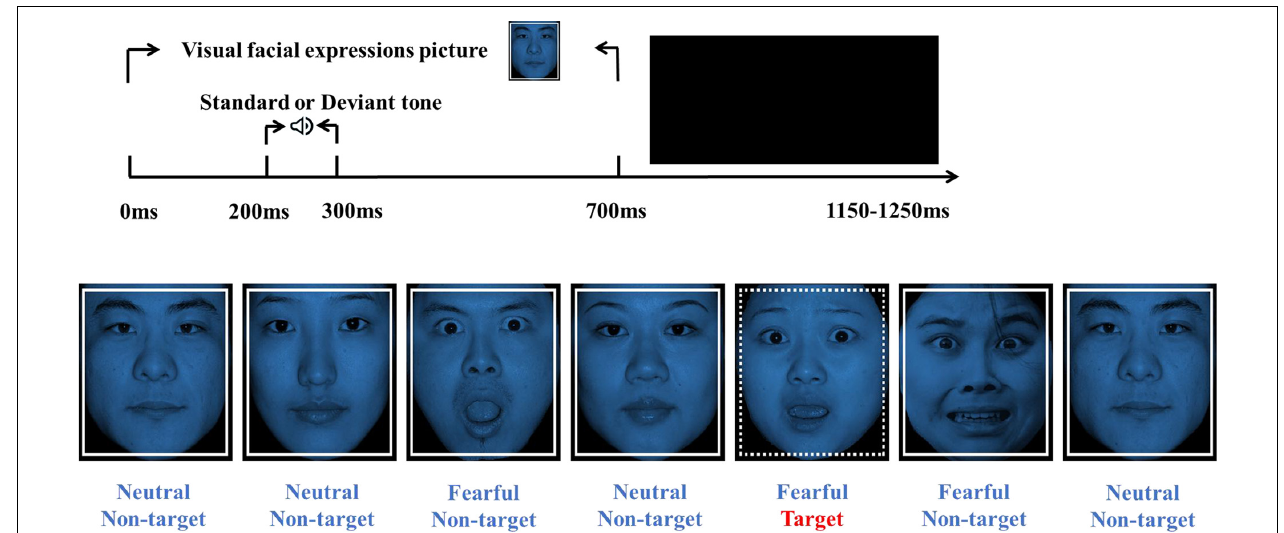
FIGURE 1 | Experimental design and a visual stimuli example. The time course of the oddball paradigm (up). Each visual facial expression picture (Non-target/Target stimulation) was presented for 700 ms, followed by the ISIs between 450–550 ms randomly. At 200 ms after picture onset, a tone (Standard or High-deviant) was presented for 100 ms. Visual stimuli are composed of non-target stimulus (solid lines) and target stimulus (dotted lines; bottom). Neutral and fearful facial expressions were half of each type of